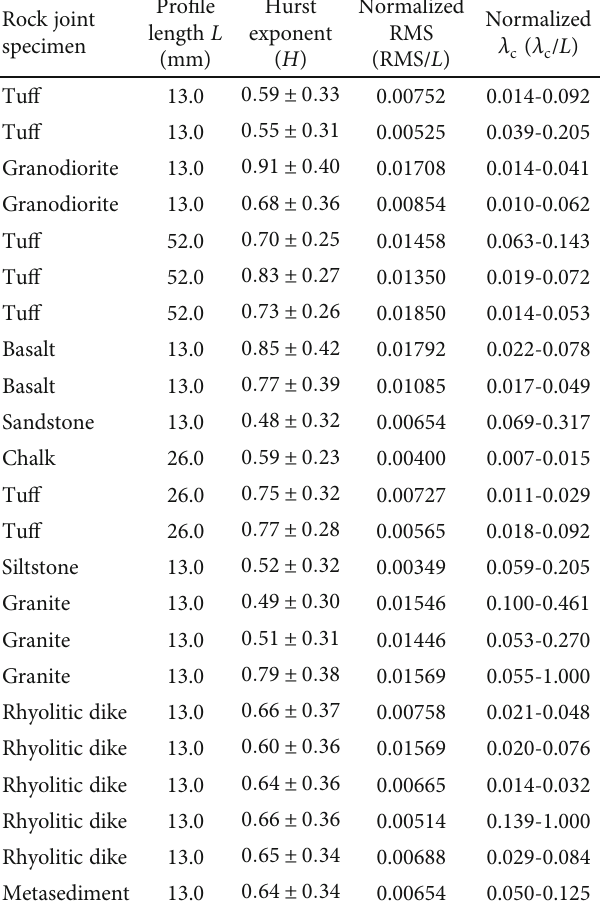
Table 1: Natural rock joint pro fi les analysis results (obtained from [28]).